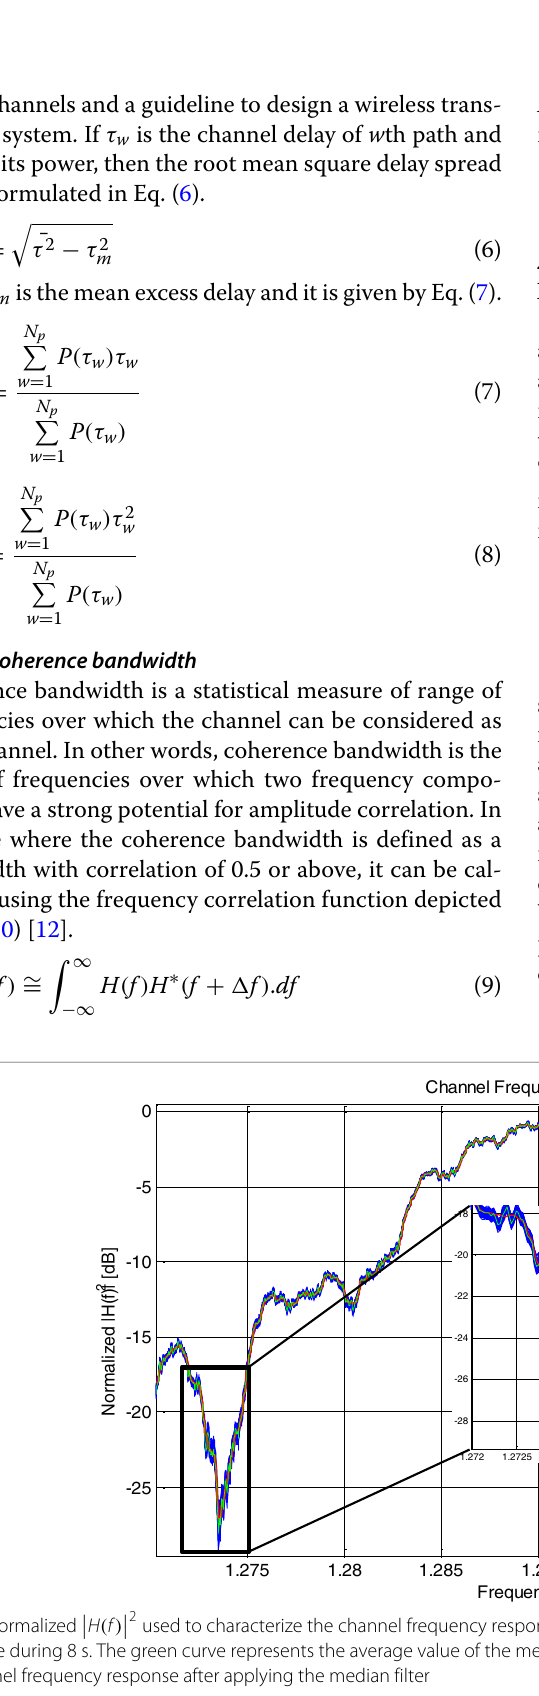
t measured channel frequency